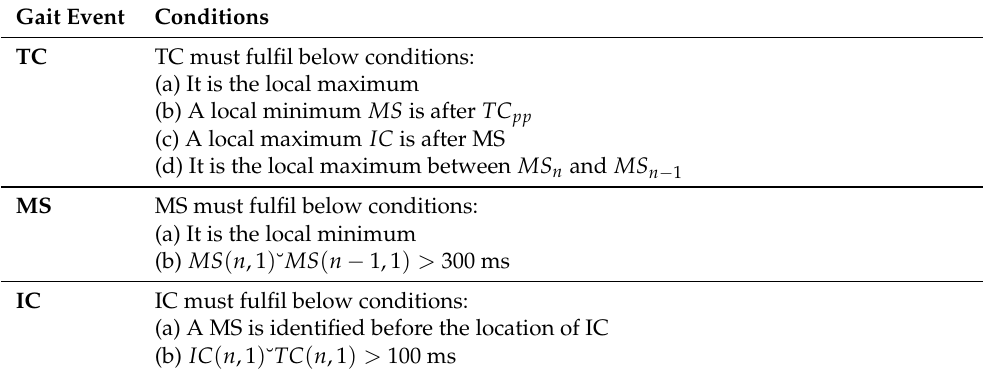
Table 1. The detection logic and conditions for IC, MS and TC